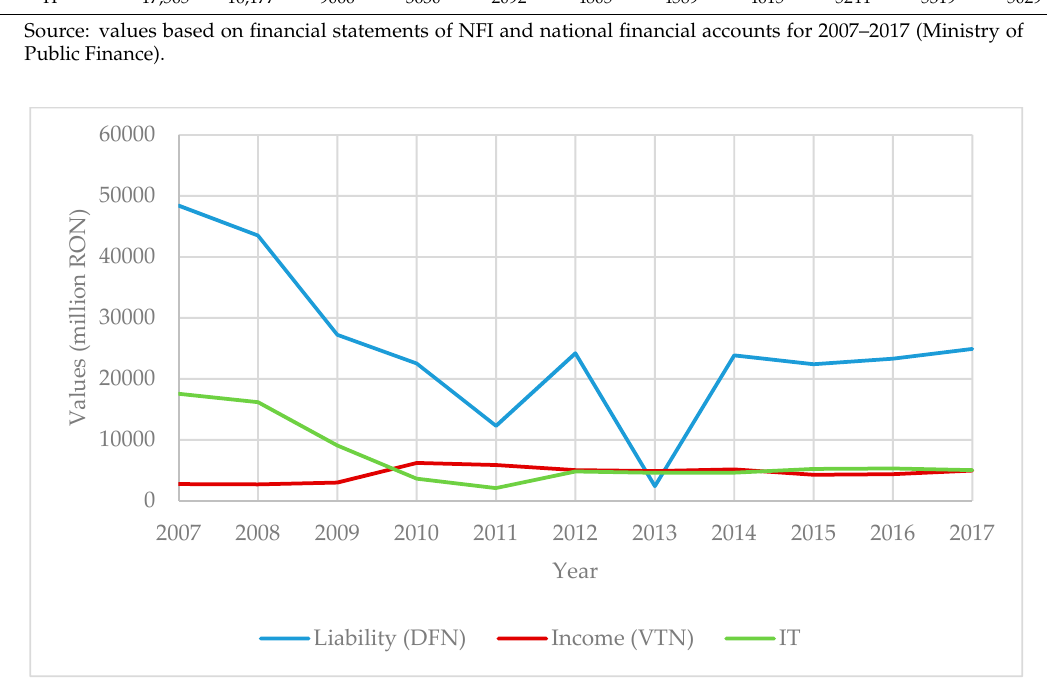
Figure 2. Debt sustainability values of the NFI (IT) sector.